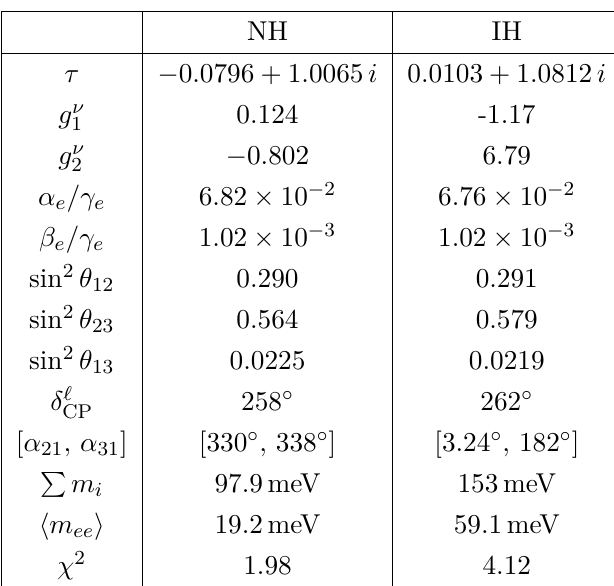
Figure 12 . The predicted h m ee i versus sin 2 θ 23 for IH.